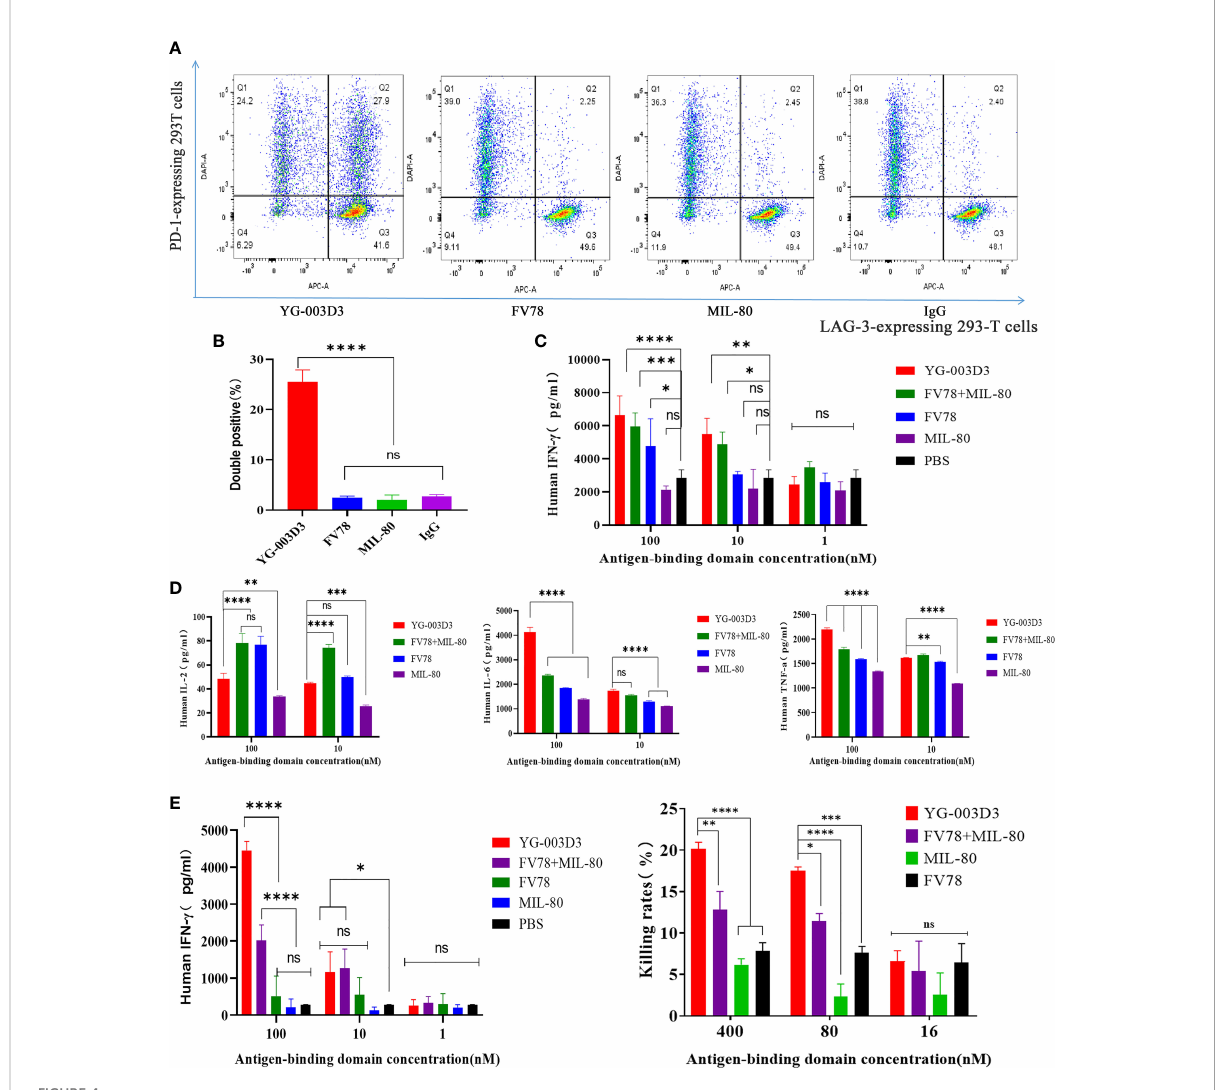
FIGURE 4 In vitro biological activity of YG-003D3. (A) CytoTell ™ Blue-labeled PD-1-expressing 293T cells and CytoTell ™ Red 650-labeled LAG-3- expressing 293-T cells were mixed 1:1, then, fl ow cytometry scatter diagram showing the percentage of dual positive cells treated with YG- 003D3, Fv78, MIL-80, respectively. YG-003D3 could have a marked increase in the crosslinking ratio of PD-1/LAG-3 dual positive cells when compared with other groups. (B) YG-003D3, Fv78, MIL-80, and control antibody IgG group double positive cell complex ratio statistics, data represent three independent experiments. (C, D) . YG-003D3 double blocking PD-L1/LAG-3 pathway can promote PBMCs activation. It can be found from the fi gure that when the concentration of the same antigen binding region was the same, YG-003D3 could promote PBMCs to secrete more IFN- g , IL-6, and TNF- a than the parental antibody. Although the promotion effect of YG-003D3 on IL-2 secretion by PBMCs was not obvious, the overall activation effect of YG-003D3 on PBMCs was signi fi cantly better than that of Fv78 and MIL-80 monoclonal antibodies. (E) YG-003D3 enhances CD4 + T cell activation. IFN- g secretion in culture was measured after co-culturing CD4 + T cells with monocyte-derived DCs for 5 days with YG-003D3, Fv78, MIL-80, or Fv78+MIL-80. The results showed that a high concentration of bispeci fi c antibody YG-003D3 had a strong effect on promoting T cell activation. F.YG-003D3 promotes PBMCs to kill tumor cells. Data are derived from human PBMCs from 3 healthy donors. All experiments were repeated two or three times. Dates were considered statistically signi fi cant when p values lower than 0.05 (*p <0.05, **p < 0.01, ***p<0.001 and ****p